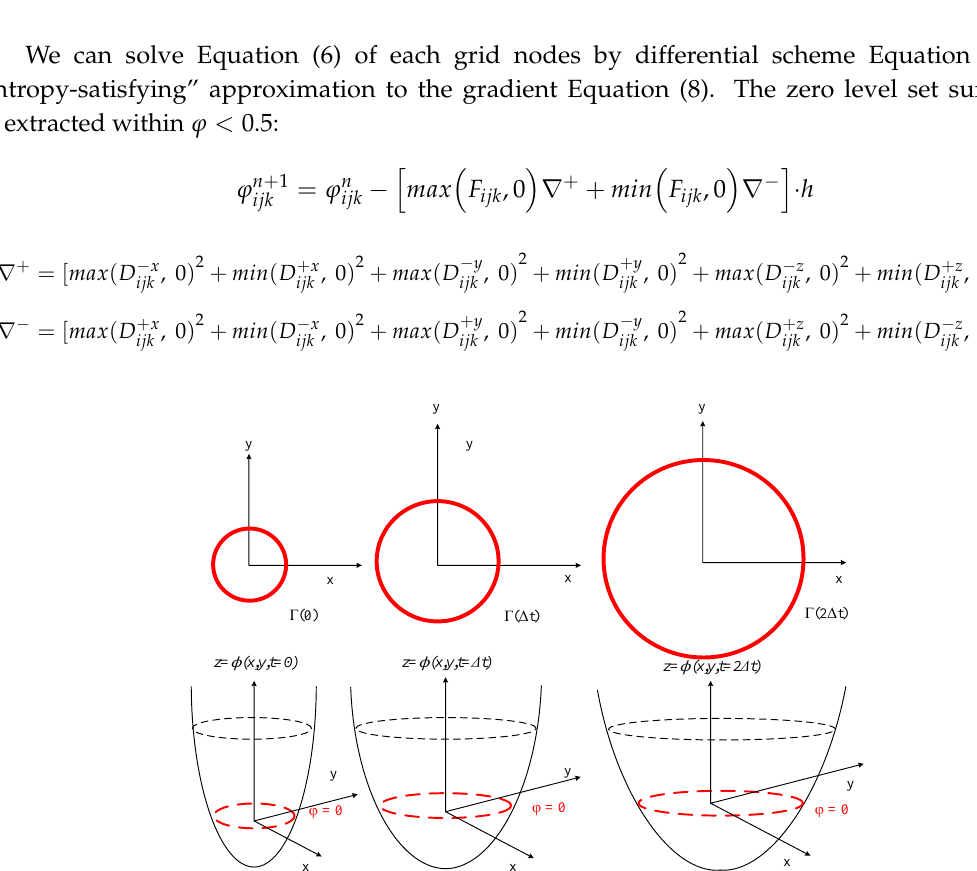
Figure 4. Illustrations of 2-D propagation of Γ ( t ) with the moving level set function ϕ .